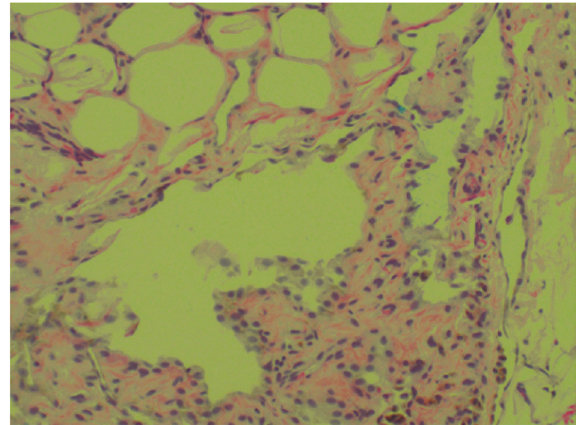
Figure 2: Case 1: Figure 2. Histology: Lipomatous tissue with focal fibrosis and old hemorrhage. There was no evidence of high grade sarcoma. Immunostains for CD31 and CD34 do not show evidence of abnormal vascular proliferation. FISH and MDM2 studies could not be performed due to lack of